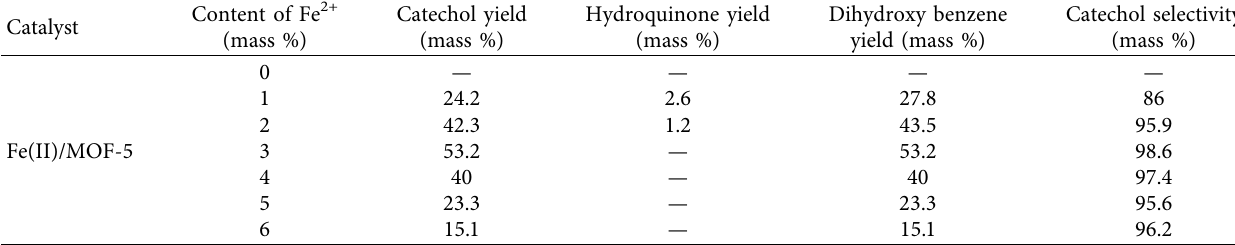
Table 2: Catalytic experimental results of phenol hydroxylation.